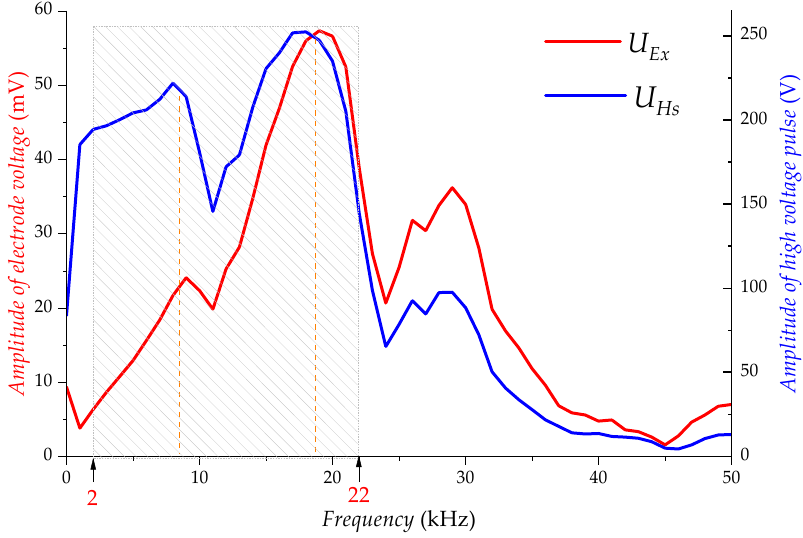
U and U (experiment). Figure 6. Frequency domain diagram of U Ex and U Hs Ex Hs